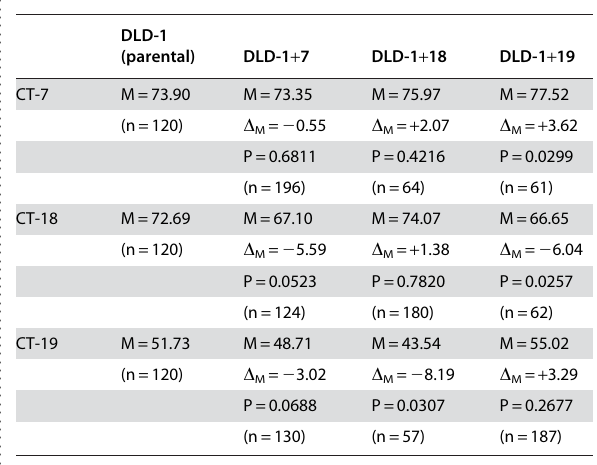
Table 1. Statistical analyses of radial distance